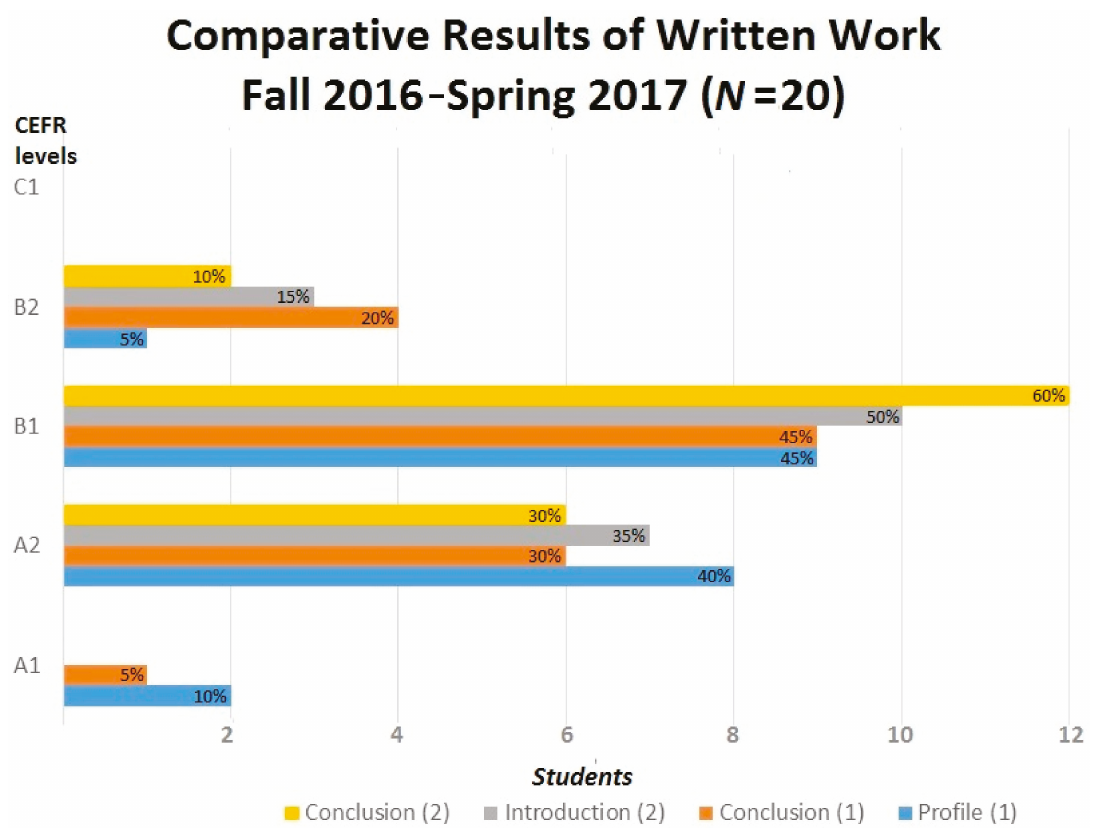
Figure 6. First and second semester written work comparison by CEFR